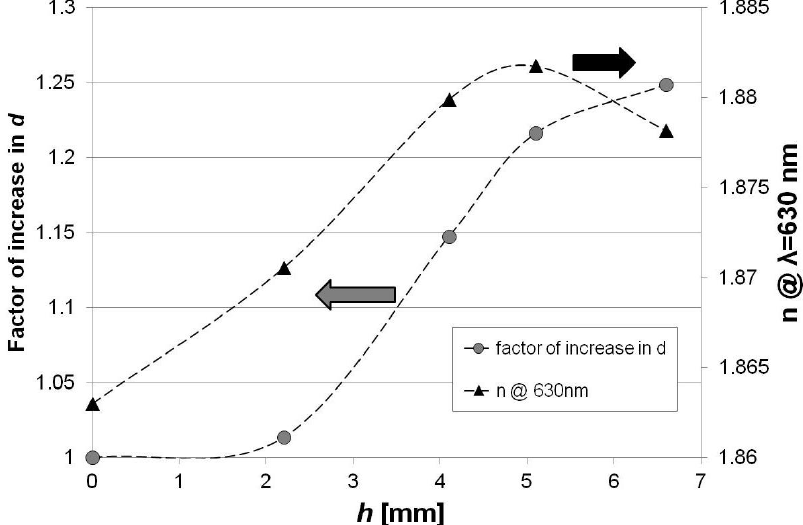
Figure 6. Evolution of d and n with distance between Si sample and holder. Thickness is referred to the value measured for sample placed directly on the